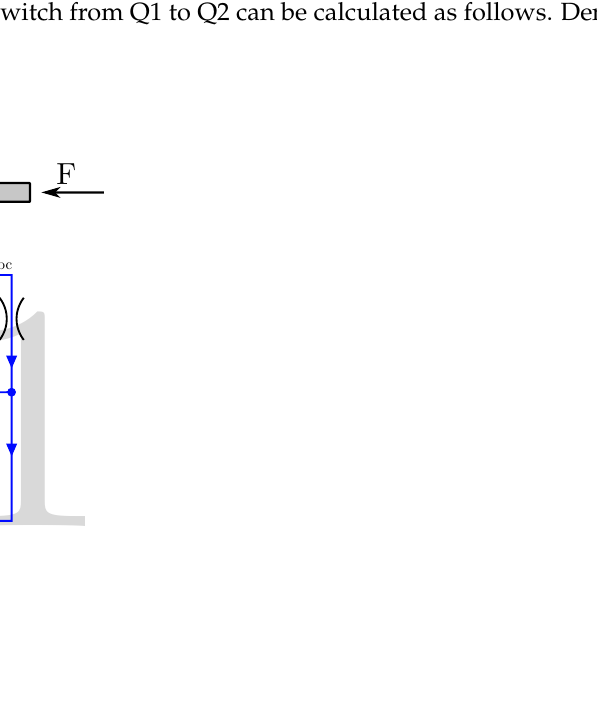
Figure 11. Clarification of denotations. The example shown is for operation in the first quadrant and the load-holding valves are on the cylinder